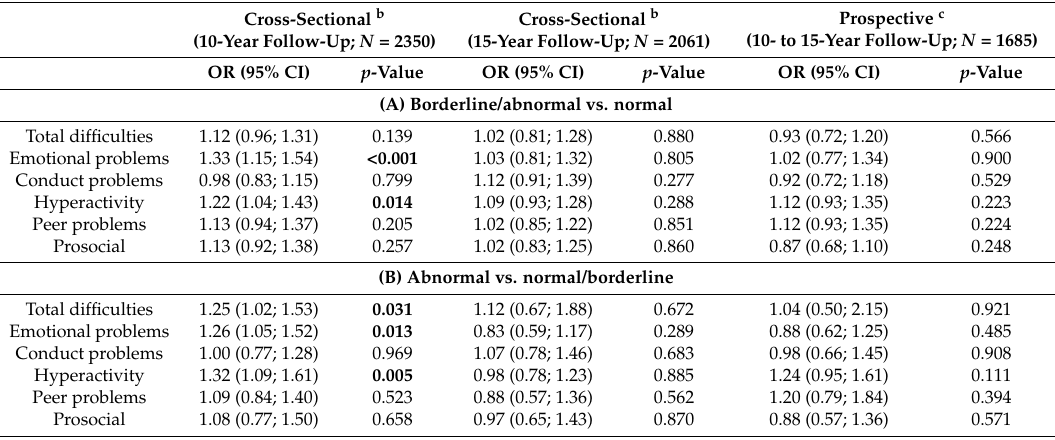
Table 2. Odds ratio (OR) and 95% CI assessing the cross-sectional and prospective associations of diet-induced acid load (PRAL) with mental health outcomes a .